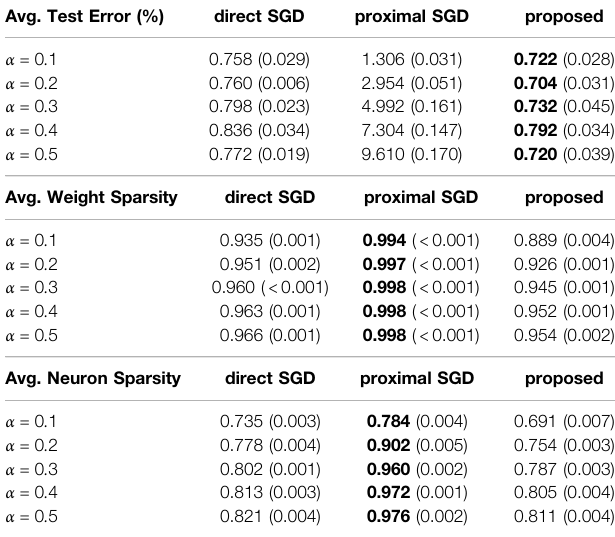
TABLE 10 | Average test error, weight sparsity, and neuron sparsity of SGL 1 -regularized Lenet-5 models trained on MNIST after 200 epochs across 5 runs. Avg. Test Error (%)